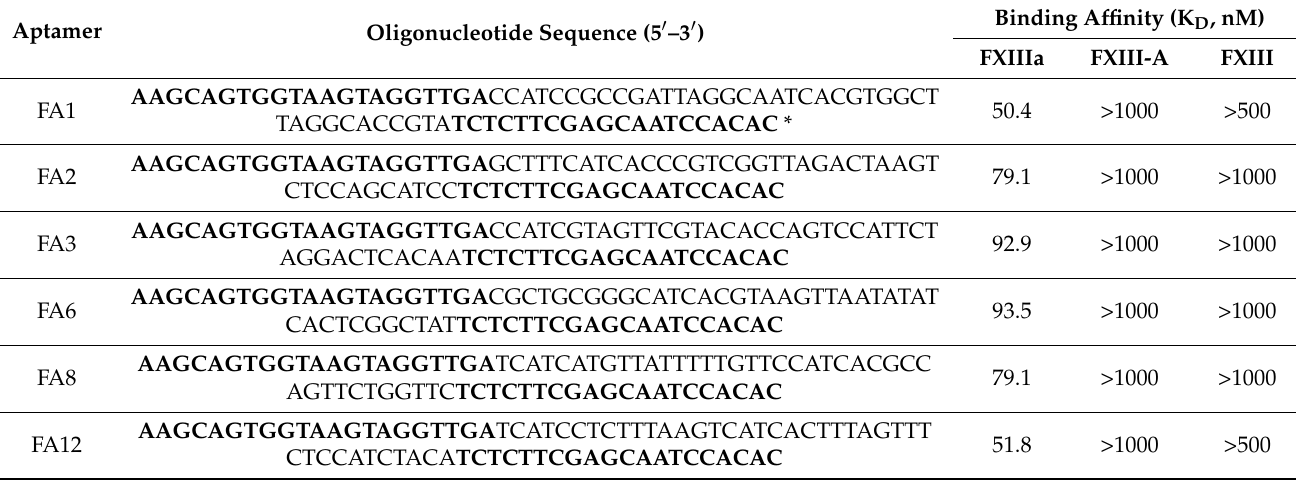
Table 1. Oligonucleotide sequence and binding affinities of aptamers to different subunits of FXIII. Aptamer Oligonucleotide Sequence (5 (cid:48) –3 (cid:48)